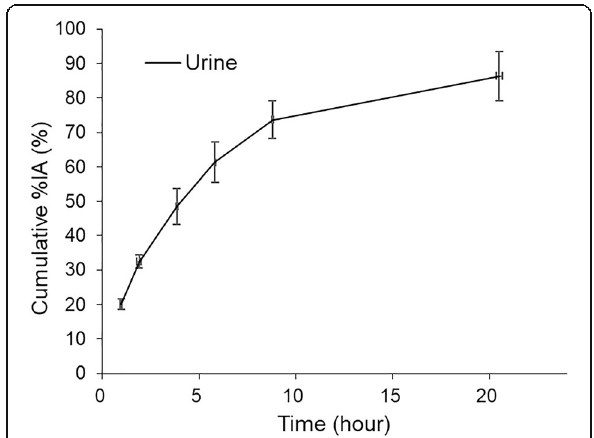
Fig. 5 [ 18 F]DiFA in urine expressed as a % of injected activity (%IA)